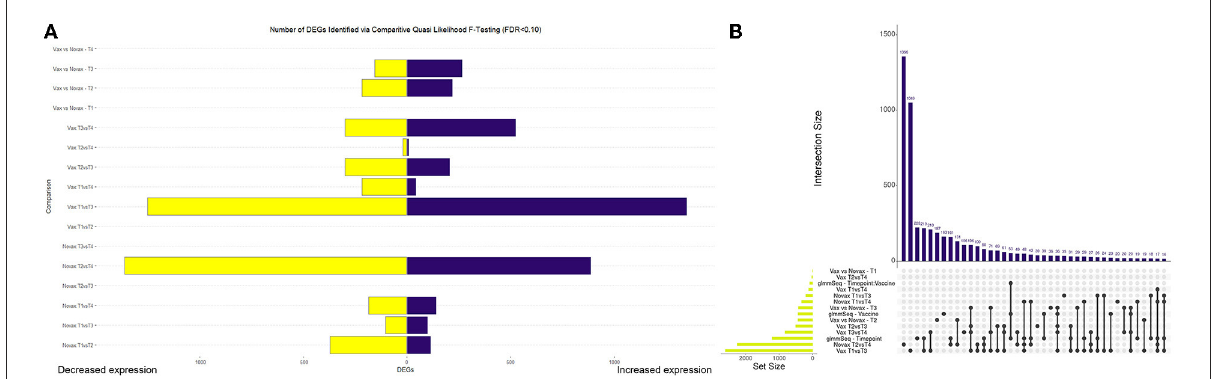
FIGURE1 Visualization of differentially expressed genes (DEGs) identified through edgeR Quasi Likelihood F-testing and glmmSeq analyses. (A) Bar graph depicting the number and directionality of DEGs found in each edgeR pairwise test. Directionality is based on the first testing group within each pairwise test. For example, Vax T3vsT4 depicts 524 DEGs upregulated and 302 DEGs downregulated at T3 when compared to T4. (B) Upset plot demonstrating the number of DEGs overlapped between all differential expression analyses. Novax T2vsT4 possessed the most (1356) unique DEGs of any analysis, while Vax T1vsT3 and glmmSeq–Timepoint possessed the highest number of genes identified in multiple analyses (219).